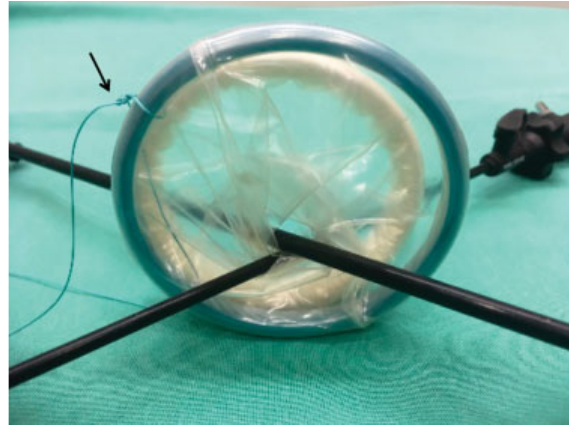
Fig. 2 Hitch stich to facilitate removal of the Alexis-Port.